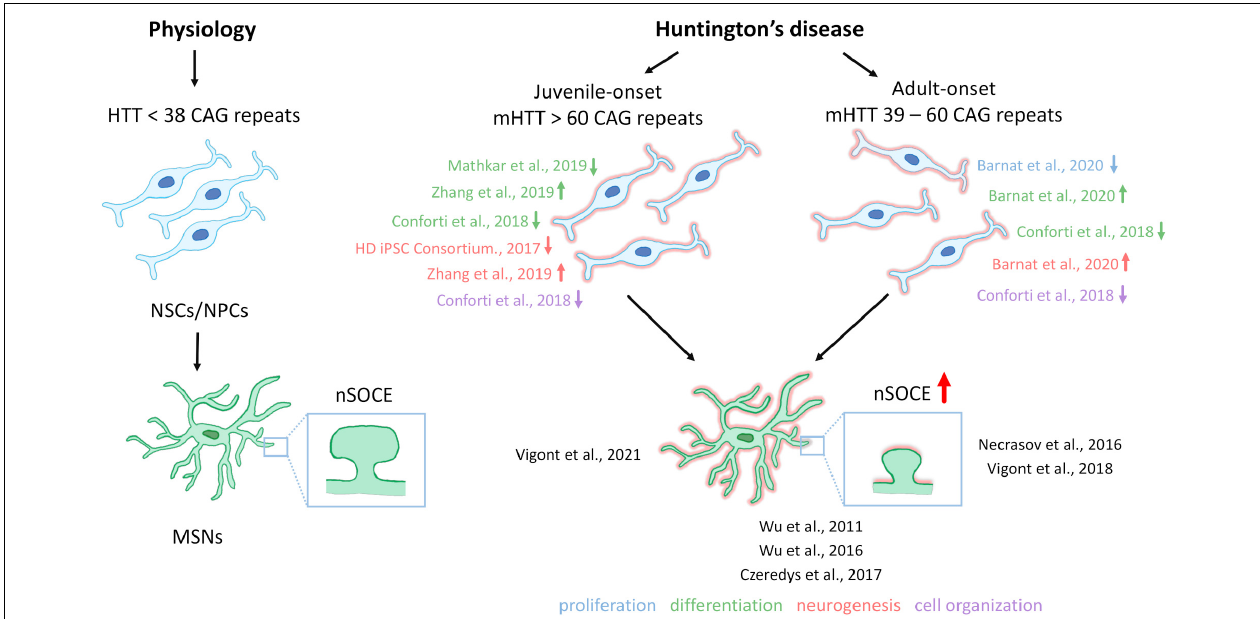
FIGURE 2 | Neural stem cells in HD pathology and contribution of SOCE to HD MSN pathology. Under physiological conditions, neural stem cells (NSCs)/neural progenitor cells (NPCs) are characterized by proper cell organization and development. The dysfunction of NSCs/NPCs under conditions of HD pathology, including both juvenile- and adult-onset, is illustrated. Juvenile-onset HD, in which mutant HTT (mHTT) contains over 60 CAG repeats, is characterized by a decrease in the differentiation of NSCs/NPCs in different in vitro models, with the exception of data that were published by Zhang et al. (2019) who discovered premature neurogenesis and neuronal differentiation (the reference is indicated in the figure by an up arrow). Furthermore, NSCs/NPCs exhibited decreases in neurogenesis and disruption in cell organization in juvenile-onset HD. In adult-onset HD, in which mHTT carries equally or more than 39 CAG repeats but not more than 60 repeats, Barnat et al. (2020) reported that mHTT dysregulates neuronal precursors differentiation and directs neurogenesis toward the neuronal lineage. In contrast Conforti et al. (2018) observed an attenuation of NSC differentiation (the reference is indicated in the figure by a down arrow). Additionally, a decrease in cell proliferation, and abnormal cell organization in adult-onset HD NSCs/NPCs in vitro and iPSC-derived cortical organoids were reported. References that correspond to the discoveries in juvenile- and adult-onset HD are shown. Under physiological conditions in wildtypes, in GABAergic medium spiny neurons (MSNs), synaptic spine stability is maintained by the SOCE process. In HD MSNs, supranormal synaptic neuronal SOCE (nSOCE) can lead to spine loss and subsequently neurodegeneration. The references that are shown in the figure relate to published data that demonstrate abnormal SOCE in induced pluripotent stem cell (iPSC)-derived MSNs from juvenile- and adult-onset HD and MSNs from the YAC128 transgenic mouse model of HD. Wu et al. (2016) detected an increase in nSOCE in synaptic spines of YAC128 MSNs. The thick red arrow represents the elevation of Ca 2 + influx via nSOCE. The up or down arrows indicate an increase, a decrease, or dysregulation in proliferation, differentiation, neurogenesis, or cell organization in juvenile- and adult-onset